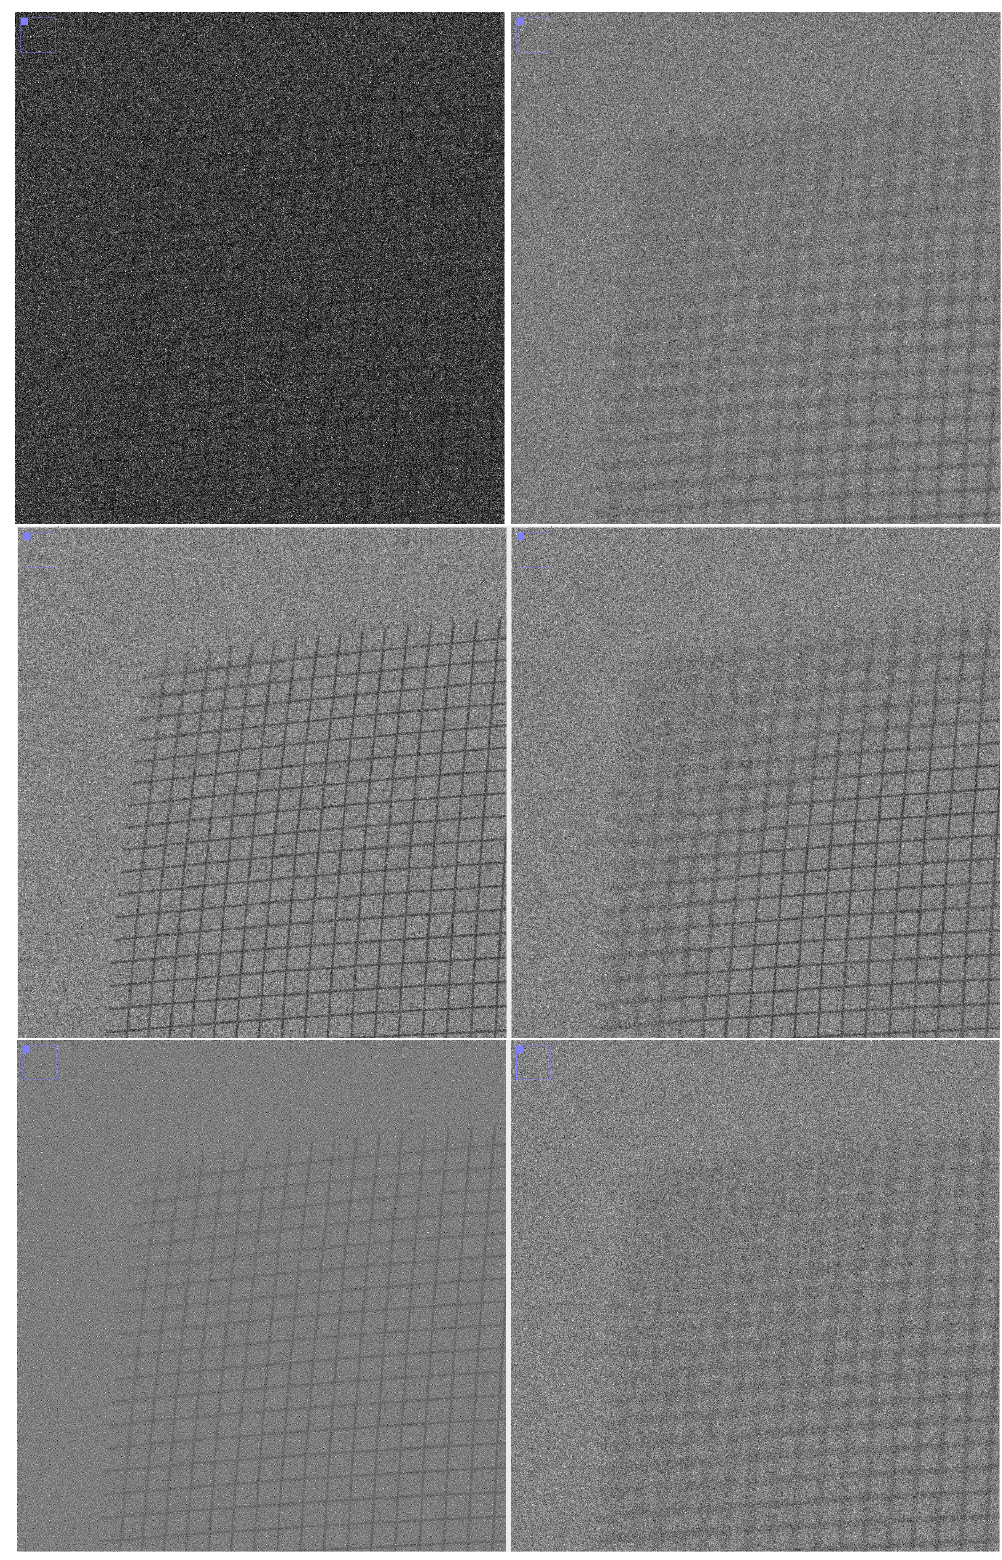
Figure 7. Detail of the frame of the phantom movie ( top left ), detail of produced micrograph, normalized: cryoSPARC ( top right ), FlexAlign ( center left ), Warp ( center right ), MotionCor2 ( bottom left ), Relion MotionCor ( bottom right